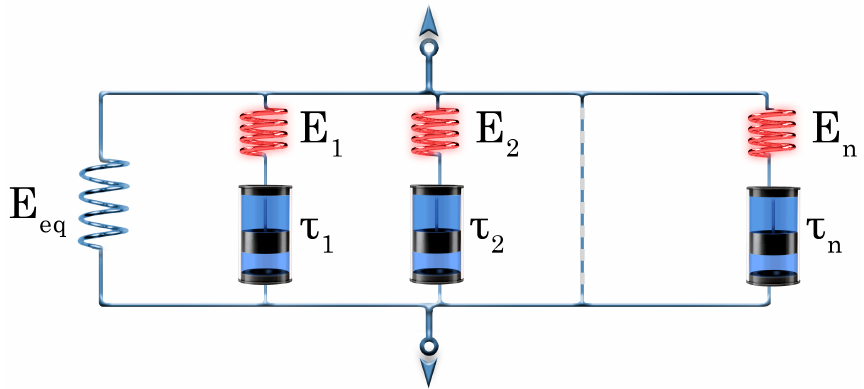
Figure 11. Multi-branched rheological model with the equilibrium ( E eq ) and non-equilibrium branches ( E 1 , τ 1 ; E 2 , τ 2 ; … and E n , τ n ). E eq , E 1 , E 2 , … E n and τ 1 , τ 2 , … τ n are the Young’s modulus of the springs and corresponding the stress relaxation times, respectively.